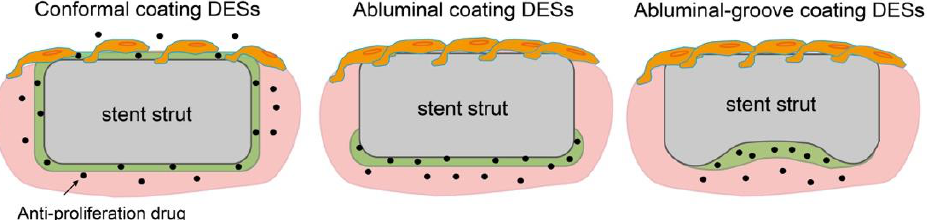
Figure 4. Schematics of endothelization on conformal coating, abluminal coating, and abluminal- groove coating DESs.